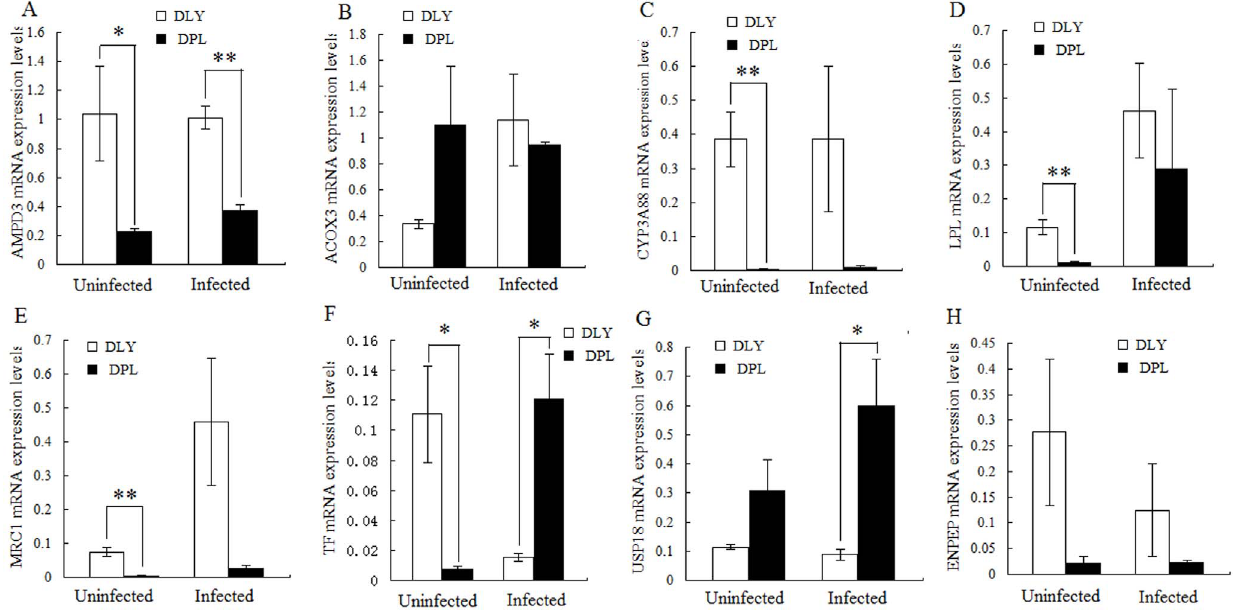
Figure 4. Comparison of 8 gene expression levels for both uninfected and infected DPL pigs with the uninfected and infected DLY pigs. * or ** indicates a statistically significant difference at p , 0.05 or 0.01, respectively.